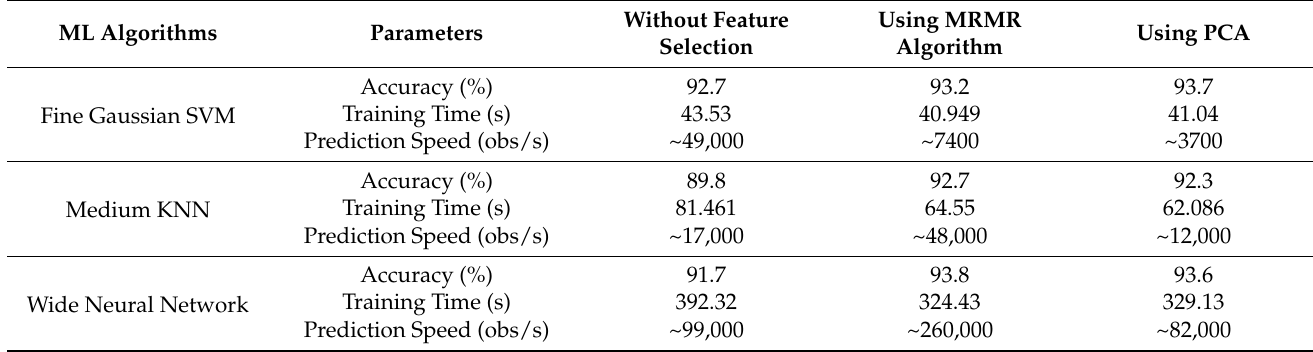
Table 3. Single-person scenario.